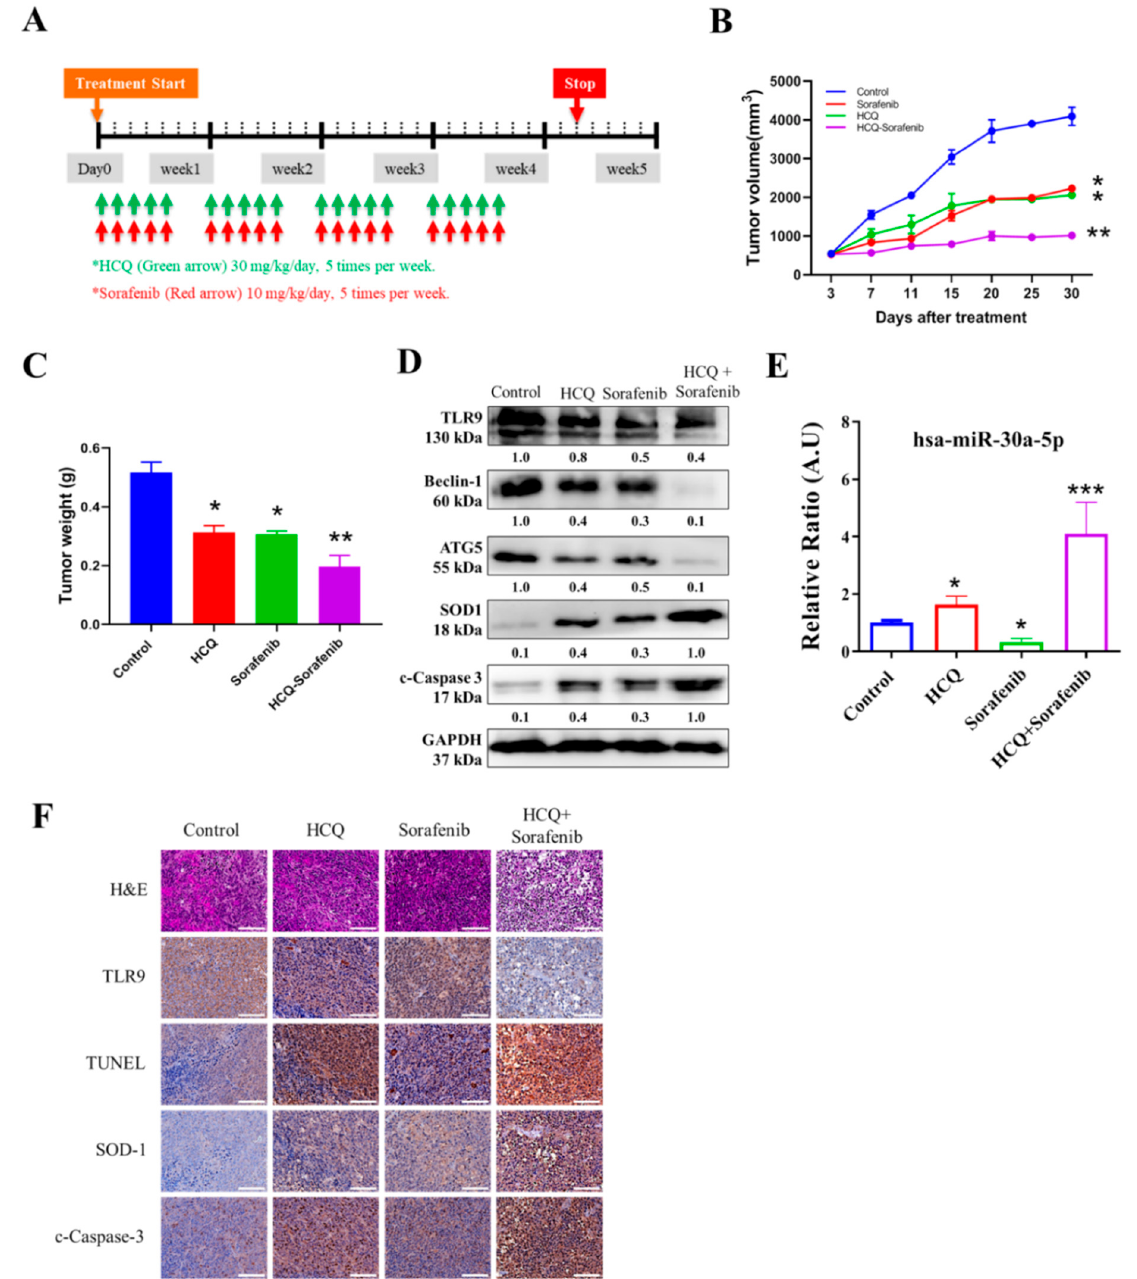
Figure 9. In vivo effect of HCQ treatment sensitizes sorafenib efficacy on sorafenib-resistant HCC cells. Effect of combi- nation therapy on the in vivo growth of HCC (Huh7-SR) cancer cells. ( A ) HCQ/sorafenib and combination treatment administration. ( B , C ) Representative images and bar plot of Huh7-SR xenograft tumor volume and weight between control and combination drug treatment groups. ( D ) Western blot analysis of expression of TLR9, autophagosome markers (ATG5 and Beclin-1), apoptotic marker (c-caspase-3), and antioxidative enzyme SOD1 expression, or GAPDH (loading control). ( E ) qRT-PCR analysis of expression of hsa-miR-30a-5p in blood serum collected from animals. ( F ) Image